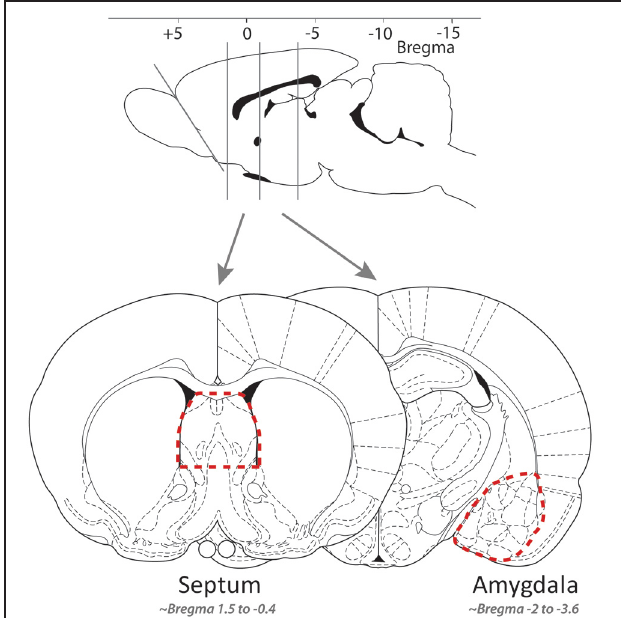
FIGURE 1 | The approximate location of the coronal slices along the rostro-caudal axis (top) and of the tissue isolated for the lateral septum and amygdala samples [bottom; adapted from Paxinos and Watson (1997)].